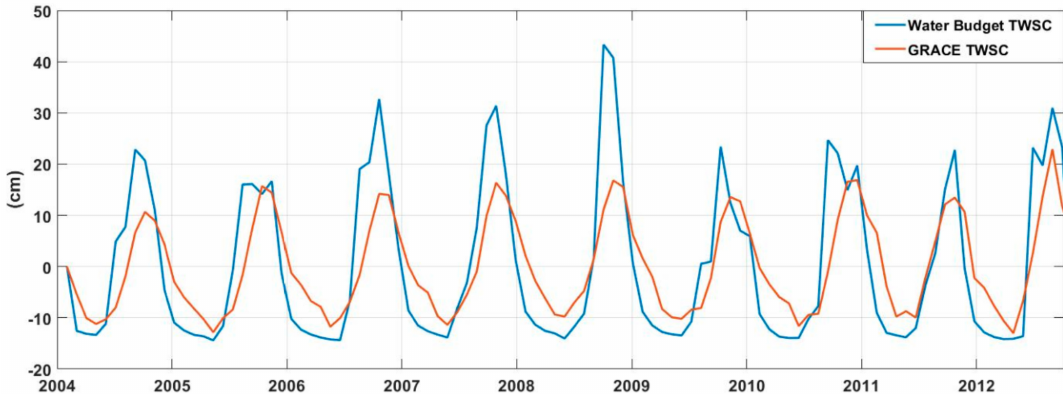
Figure 5. Comparison between GRACE terrestrial water storage capacity (TWSC) and derived water balance TWSC from 2004 to 2012 at the location of longitude 12.5 and latitude 9.5.